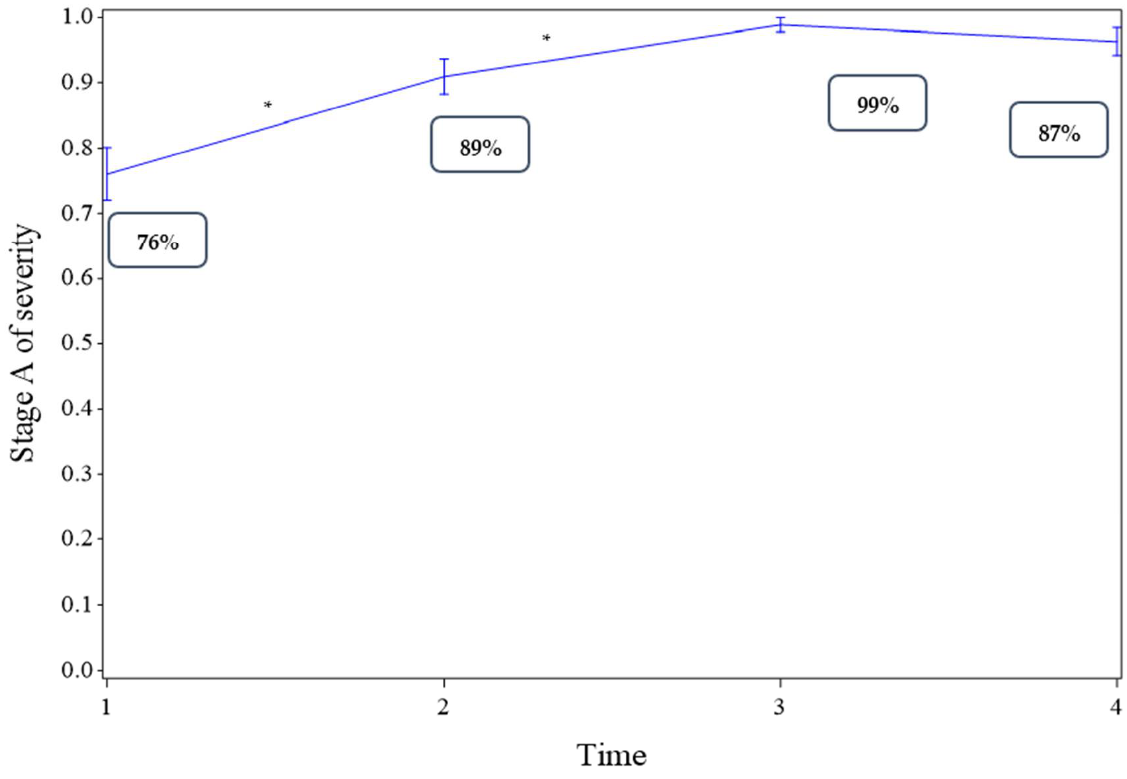
Figure 2. Changes in the proportion of patients in the least severe category (Stage A) for the severity of addictive disorders estimated using generalized estimating equations (GEE). A significant time effect is indicated by “*”. Time 1: at entry into the specialized center (inclusion); Time 2: last visit to the specialized center; Time 3: at entry into primary care; Time 4: last visit to primary care.